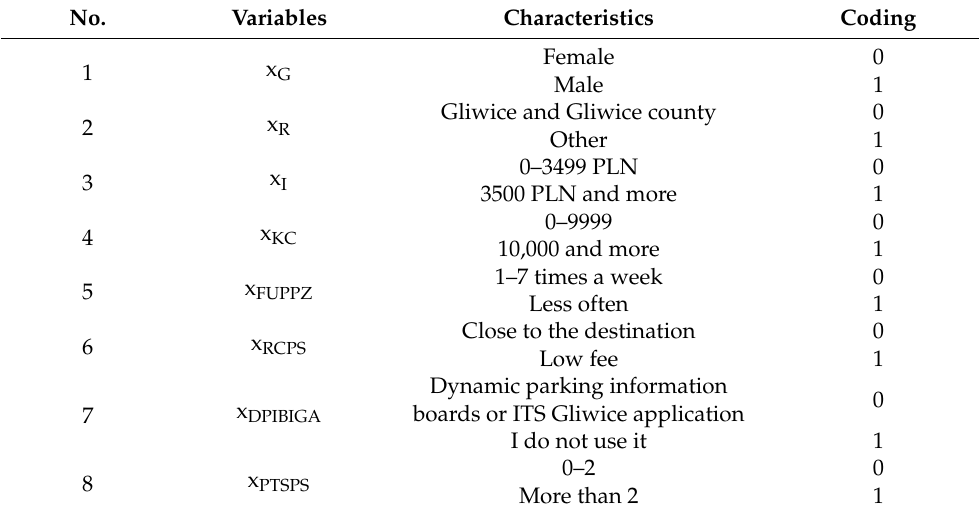
Table 3. Coding for particular characteristics of variables.